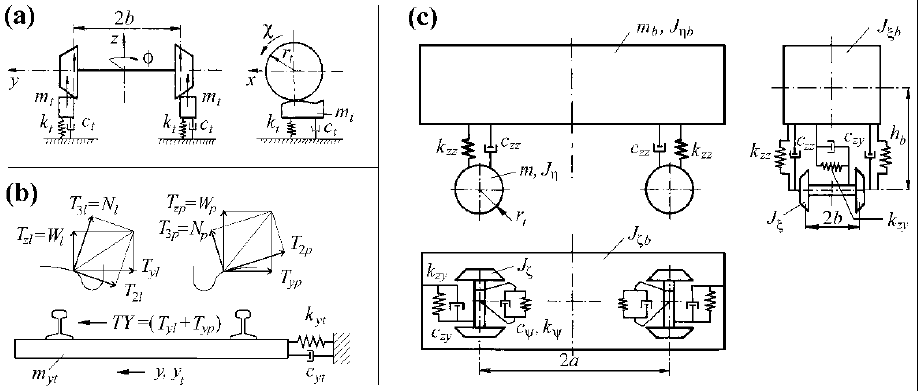
Figure 1. 2-axle vehicle model: ( a ) Track vertically, ( b ) track laterally, ( c ) vehicle.